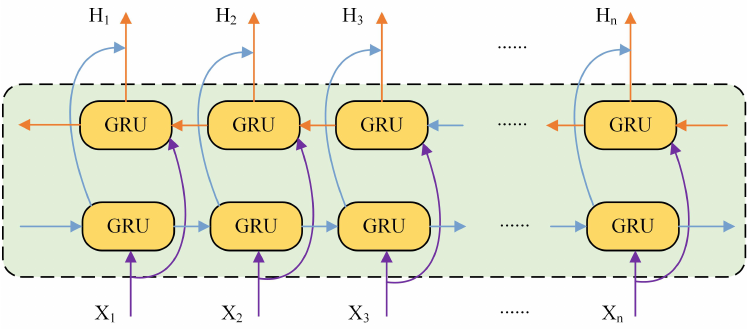
Figure 8. Structure diagram of